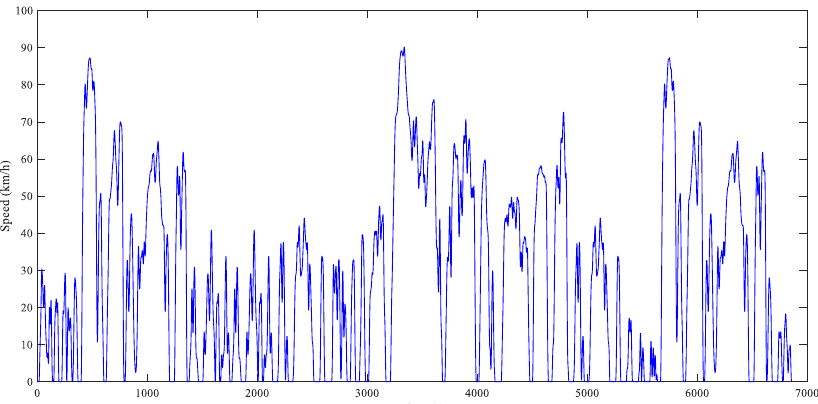
Figure 12. The driver’s actual travel cycle condition.